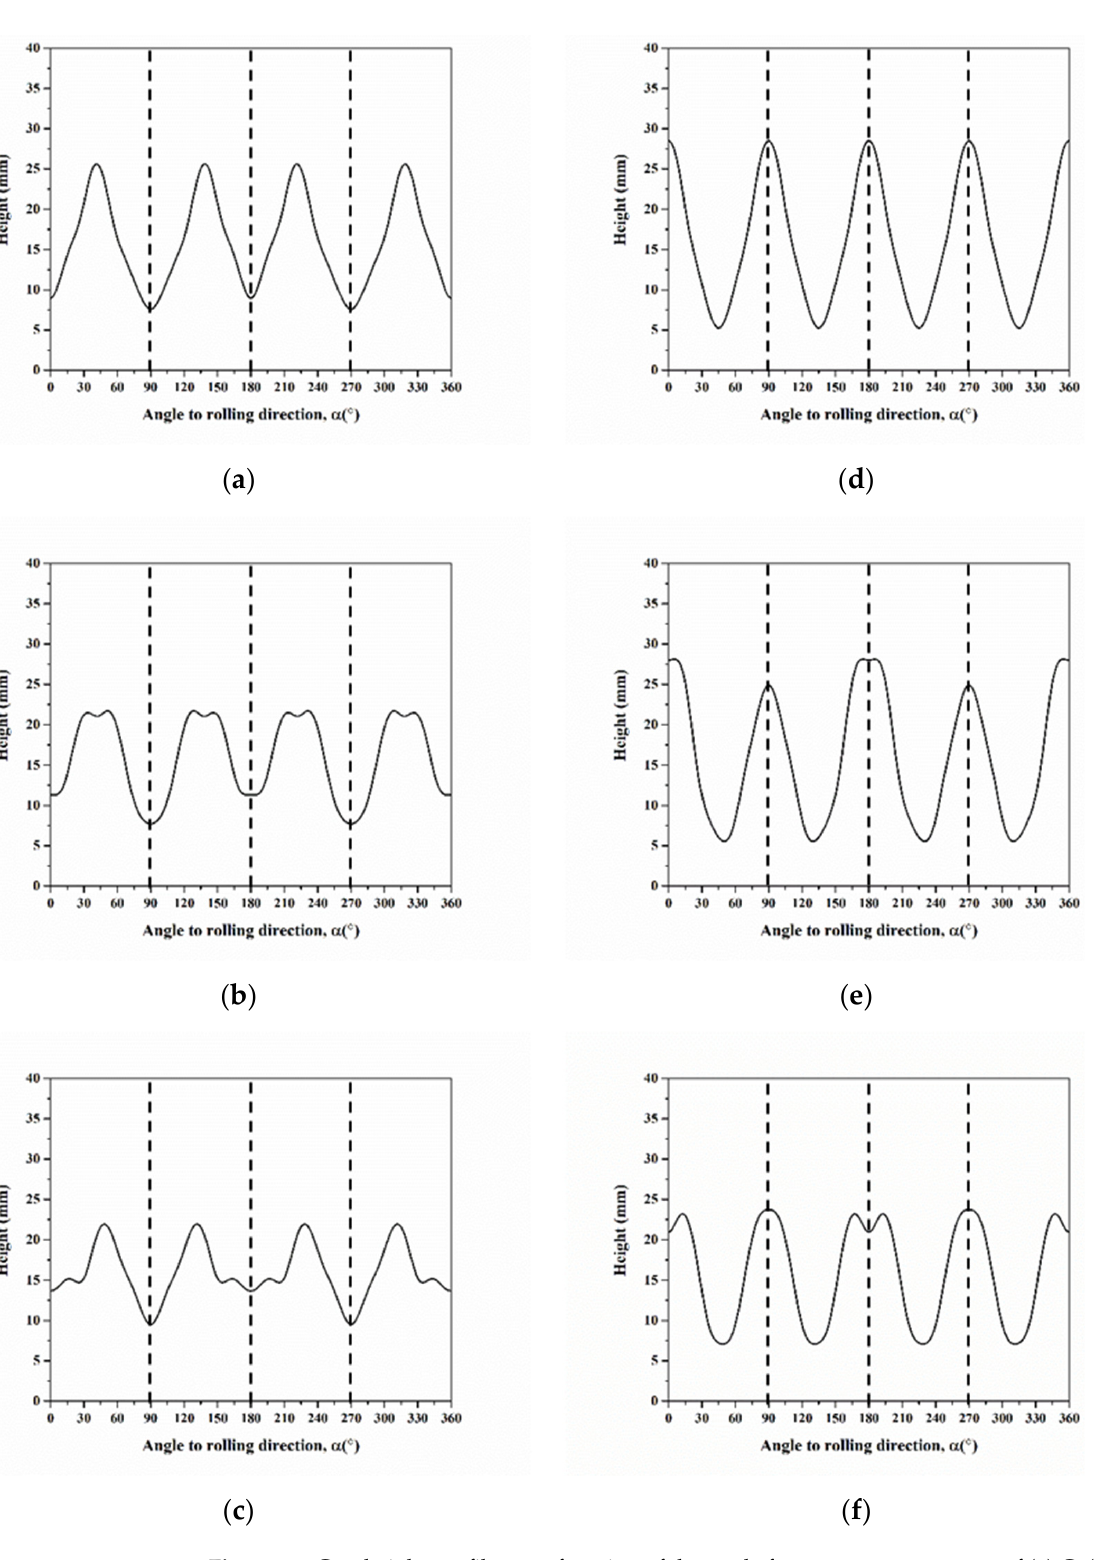
Figure 16. Cup height profiles as a function of the angle for texture components of ( a ) C, ( b ) S, ( c ) B, ( d ) Cube, ( e ) r-Cube, and ( f ) G considering 10° orientation spread.